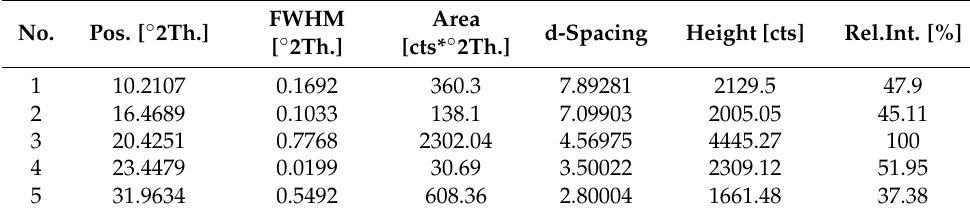
Table 1. X-ray diffraction peaks of BX.